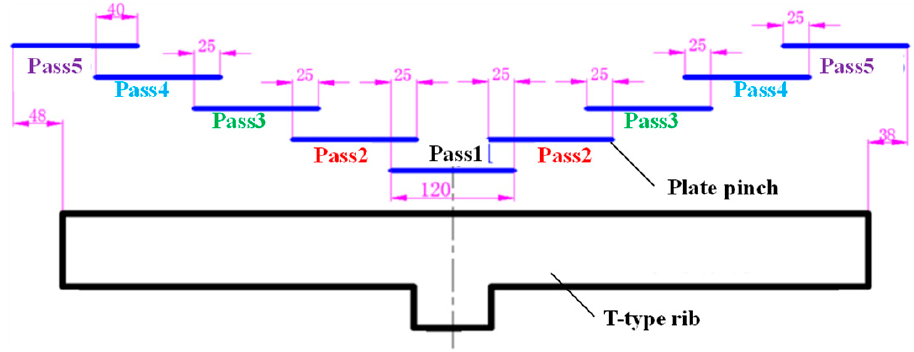
Figure 3. Schematic diagram of stepwise cold pressing process.